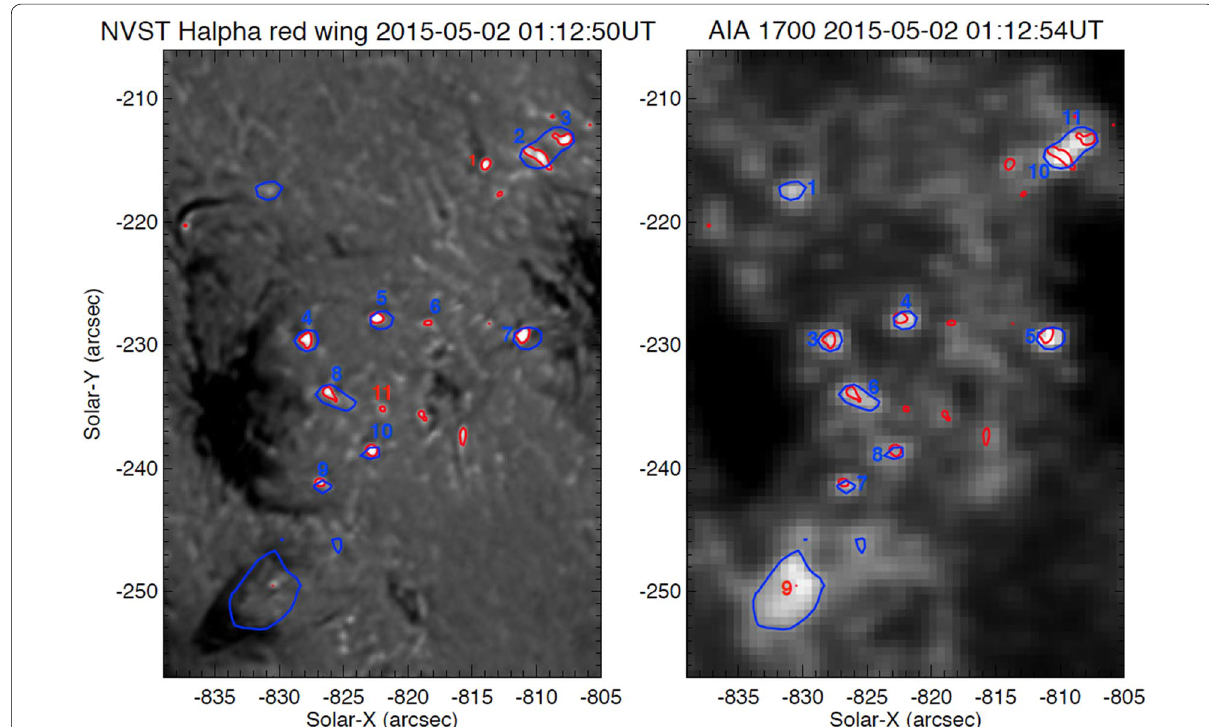
Fig. 2 Images of Hα red wing (left panel) and 1700 Å (right panel) taken at 01:12 UT on 2015 May 2. Only part of the full field of view is shown here. The red and blue contours mark the brightest pixels in the Hα red wing and 1700 Å images, respectively, using the intensity thresholds mentioned in “Observations and data analysis” section. Identified EBs are indicated by the numbers in the left image, where the blue and red numbers indicate EBs that are related or not related to BPs, respectively. In the right image, the blue and red numbers indicate BPs that are related or not related to EBs, respectively